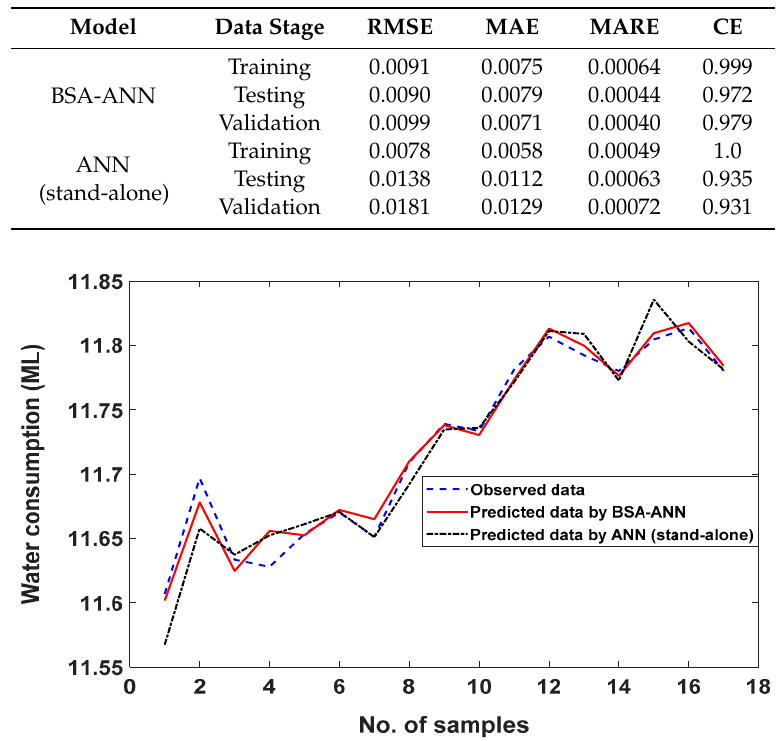
Table 3. Performance evaluation for validation data